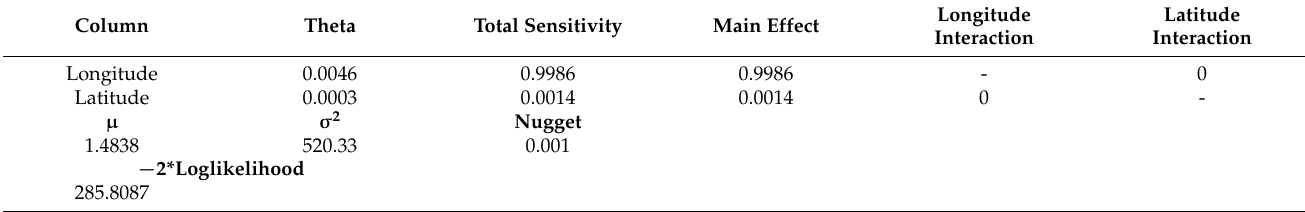
Table 3. Gaussian process model of %LAA-950insp-based COPD-E severity and progression: longitude, and latitude. Column